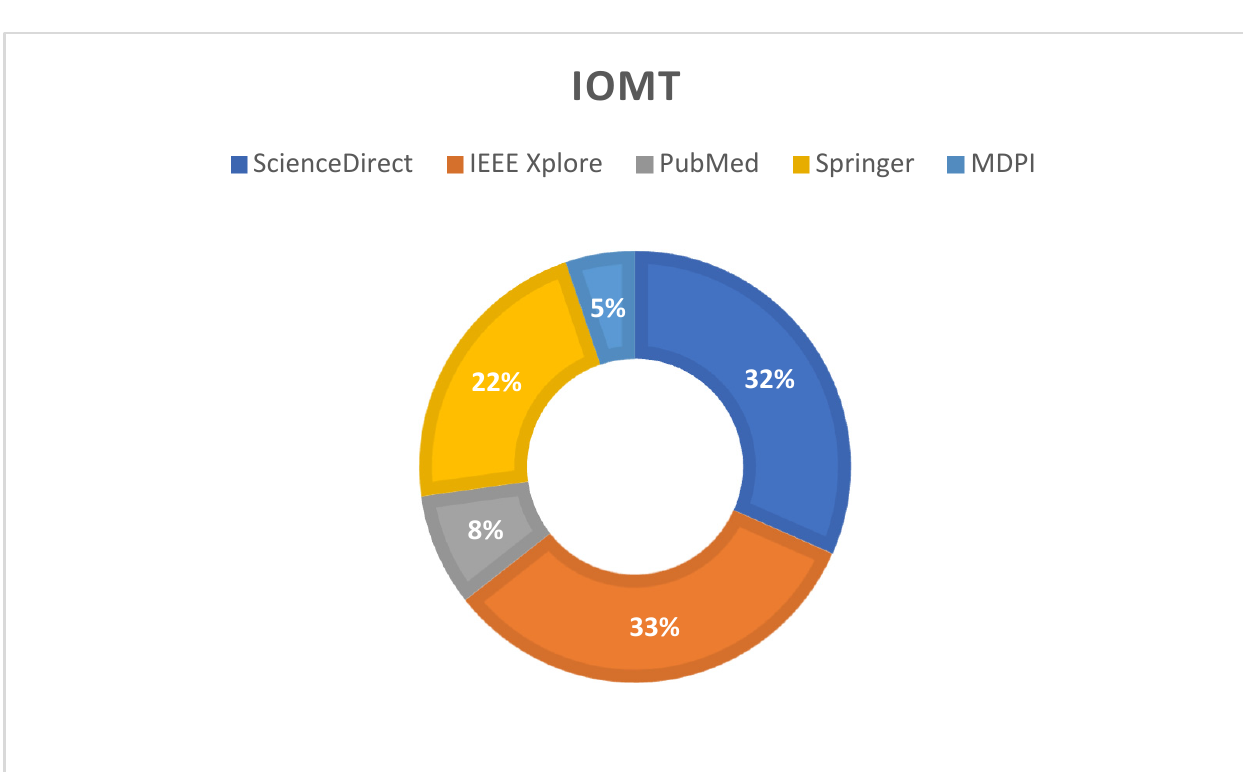
Figure 9. Search result for term IoMT.